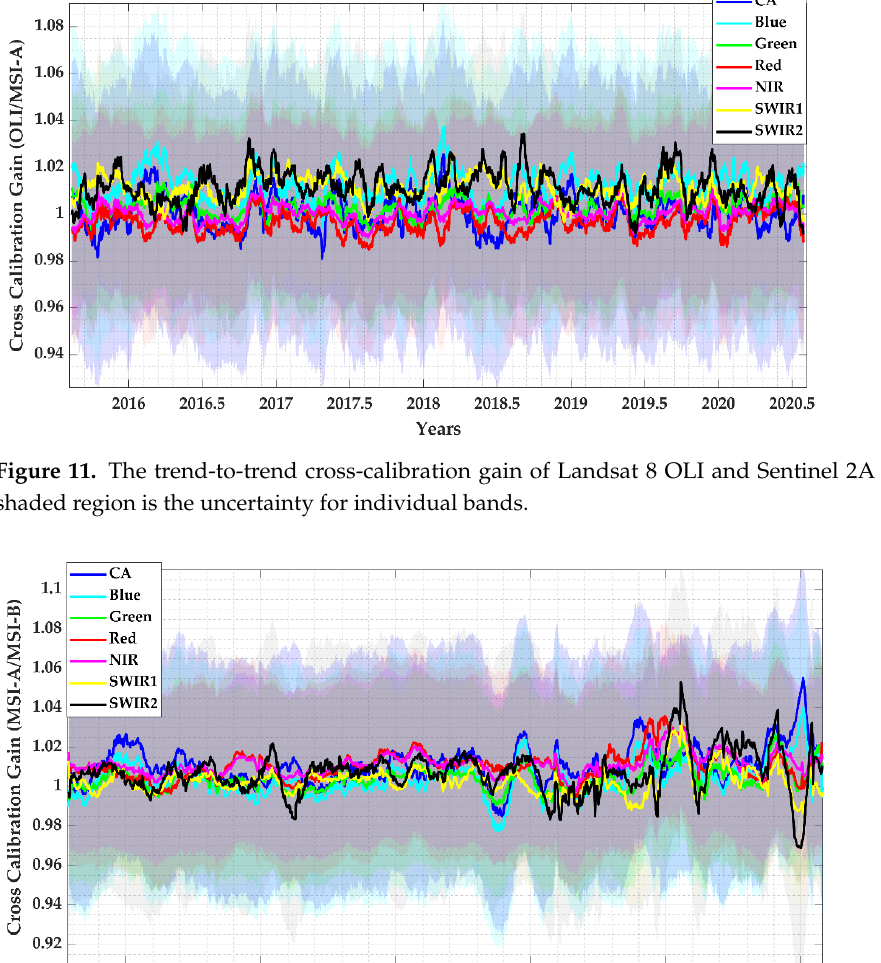
Figure 13. The trend-to-trend cross-calibration gain of Landsat 8 OLI and Sentinel 2B MSI. The shaded region is the uncertainty for individual bands.